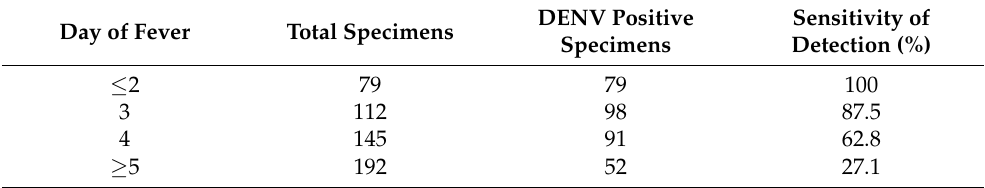
Table 5. Detection efficiency of the 3 (cid:48) -UTR RT-PCR assay according to day of fever. Day of Fever Total Specimens